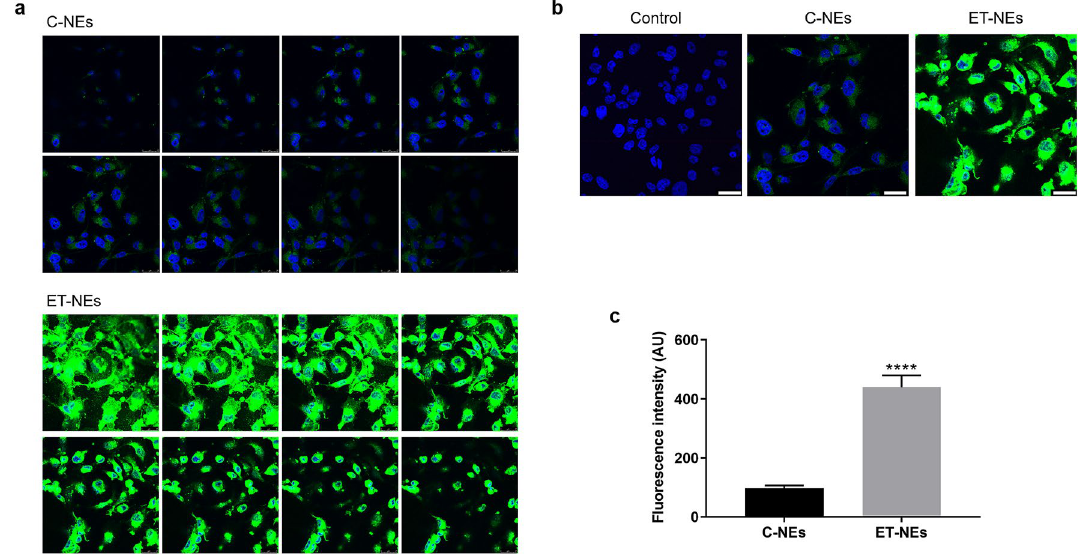
Figure 4. Internalization of NEs in MDA-MB 231 cells. ( a ) Gallery of confocal microscopy images of MDA-MB 231 cells incubated with 150 µg/mL of C-NEs and ET-NEs labeled with TopFluor-PC (green channel) for 4 h at 37 ºC. ( b ) Representative confocal microscopy single-plan image of control vs C-NEs and ET-NEs internalization by MDA-MB 231 cells. ( c ) Fluorescence intensity (AU, arbitrary units) of two maximum projection images (resultant from the combination of all the sections shown in ( a )) was determined using ImageJ software. Statistical analysis was performed using t test. P value **** p < 0.0001. Cell nuclei was stained with Hoechst (blue channel). Scale bars correspond to 25